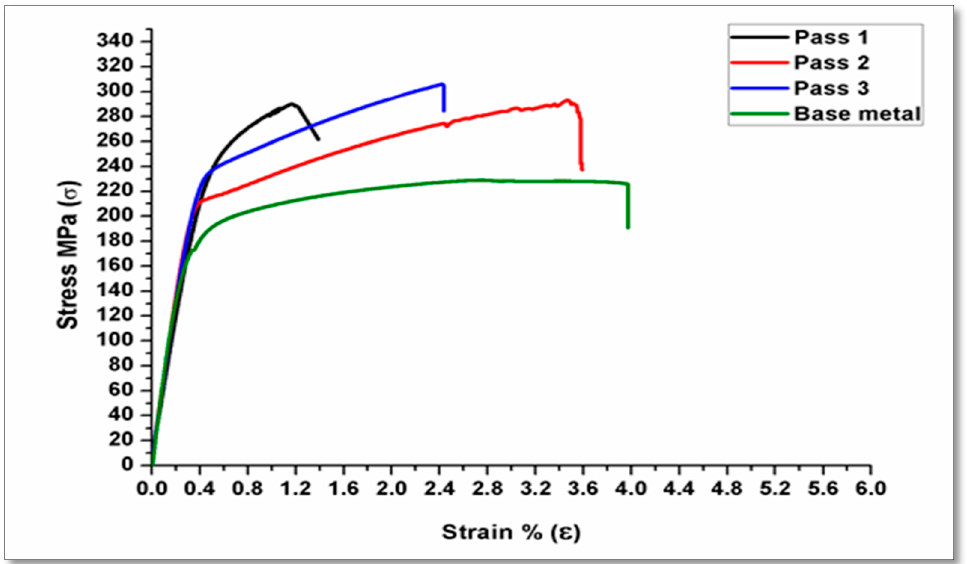
Figure 4. Effect of pass number on tensile strength at 900 rpm with a 15 mm/min travel speed.